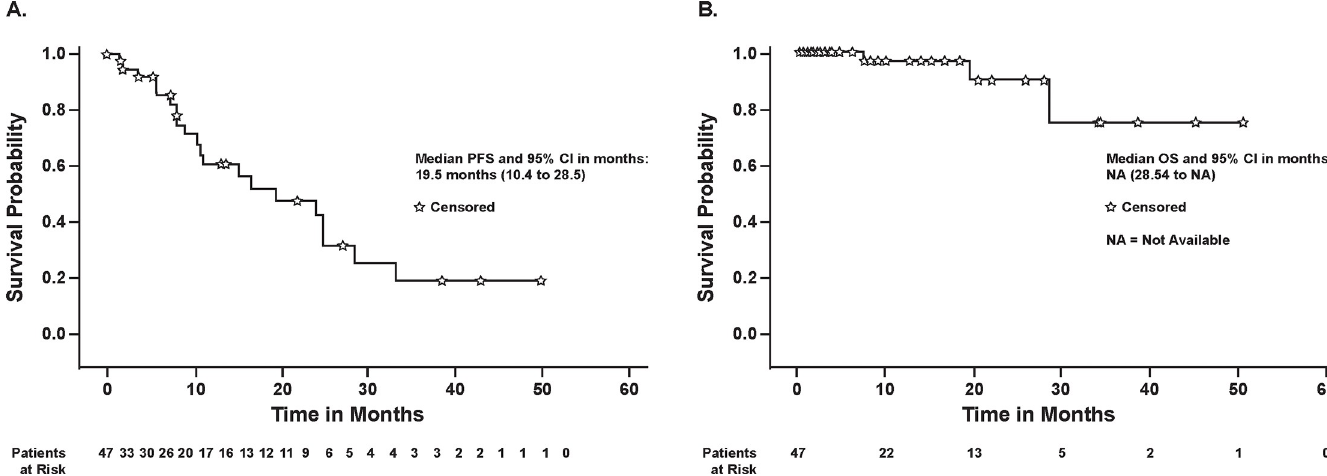
Fig 3. Progression-free survival (A) and overall survival (B) for the treated population. $ , censored; CI, confidence interval; NA, not assessable; OS, overall survival; PFS, progression-free